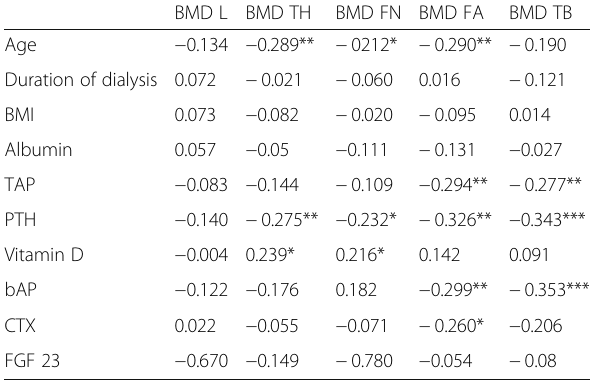
Table 7 Comparison between patients with and